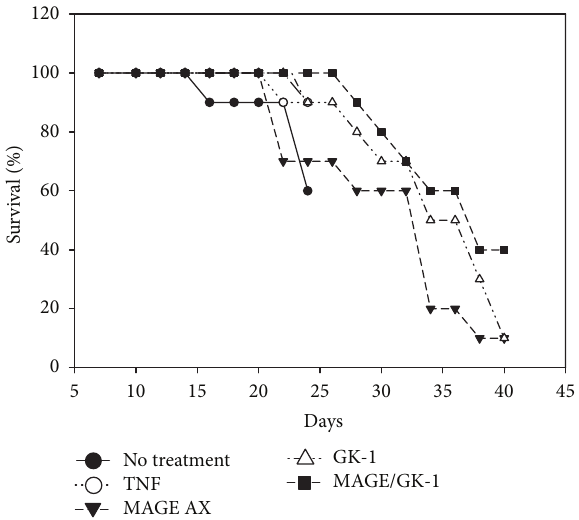
Figure3:Micesurvival.Survivalofmicewithmelanomainoculated with BMDCs matured with TNF 𝛼 and treated with MAGE-AX, GK- 1, or MAGE-AX/GK-1. The MAGE-AX/GK-1 group was the one which had a higher survival rate: 40% up to 1.5 years after being inoculated with the BMCDs. It is followed by the GK-1, MAGE-AX, TNF 𝛼 , and untreated group (WT), respectively.